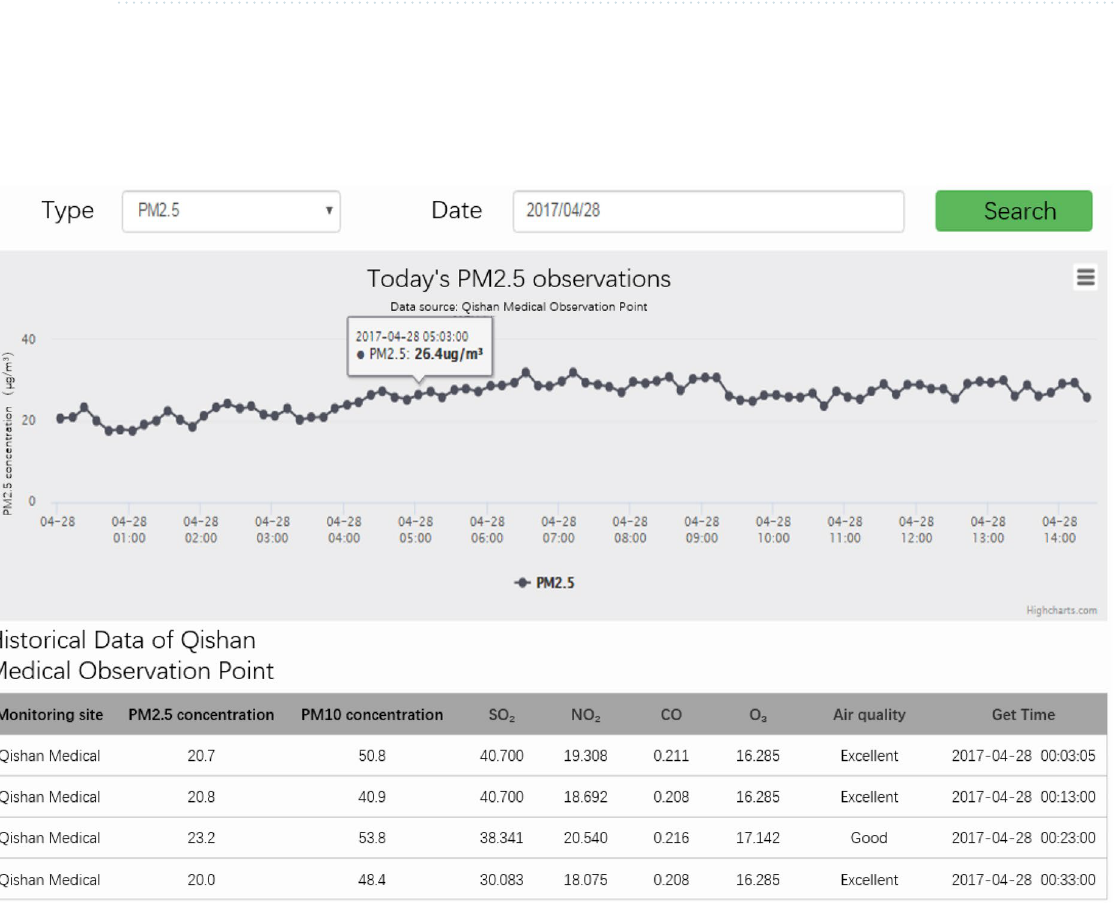
Figure 9. Application module: Historical